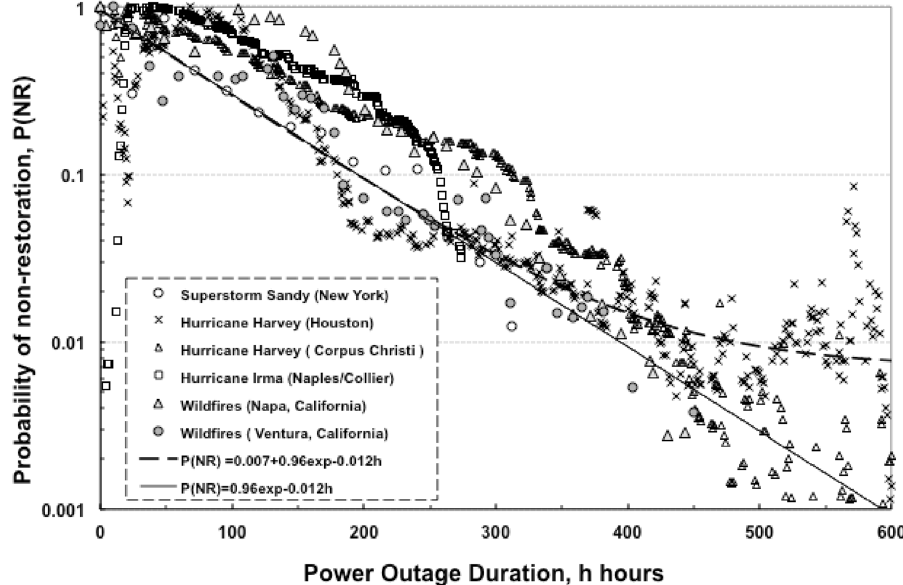
Fig. 2 Outage probability data for Hurricanes Harvey and Irma compared to Superstorm Sandy and Californian wildfires, and to the theoretically-based trend lines from Fig. 1 and Eq.